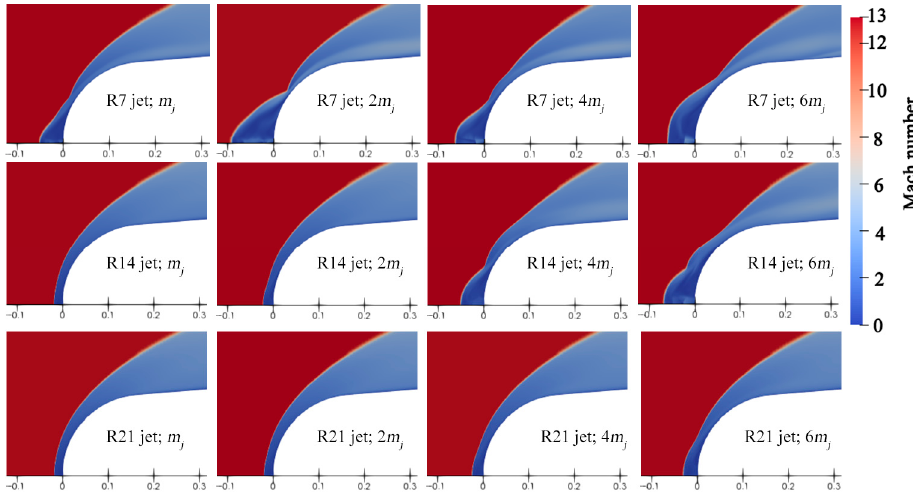
Figure 11. Jet modes of R7, R14, and R21 jets with the same flow rate.